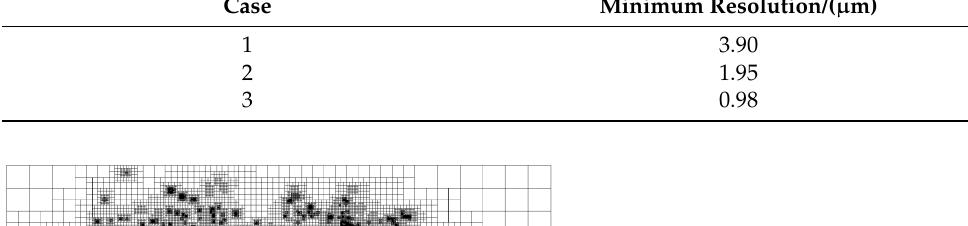
Figure 1. The schematic diagram of computational domain. Three different grid resolutions are selected for testing. The maximum scale of the three grids is 0.125 mm, and the minimum grid scale is shown in Table 2. Figure 2 shows the distribution of the adaptive mesh of case 3 on the axisymmetric plane. It can be clearly seen that the grid near the gas–liquid interface is densified level by level (darker color), while the grid distribution is sparse for the surrounding gas area. Table 2. The minimum grid resolution.